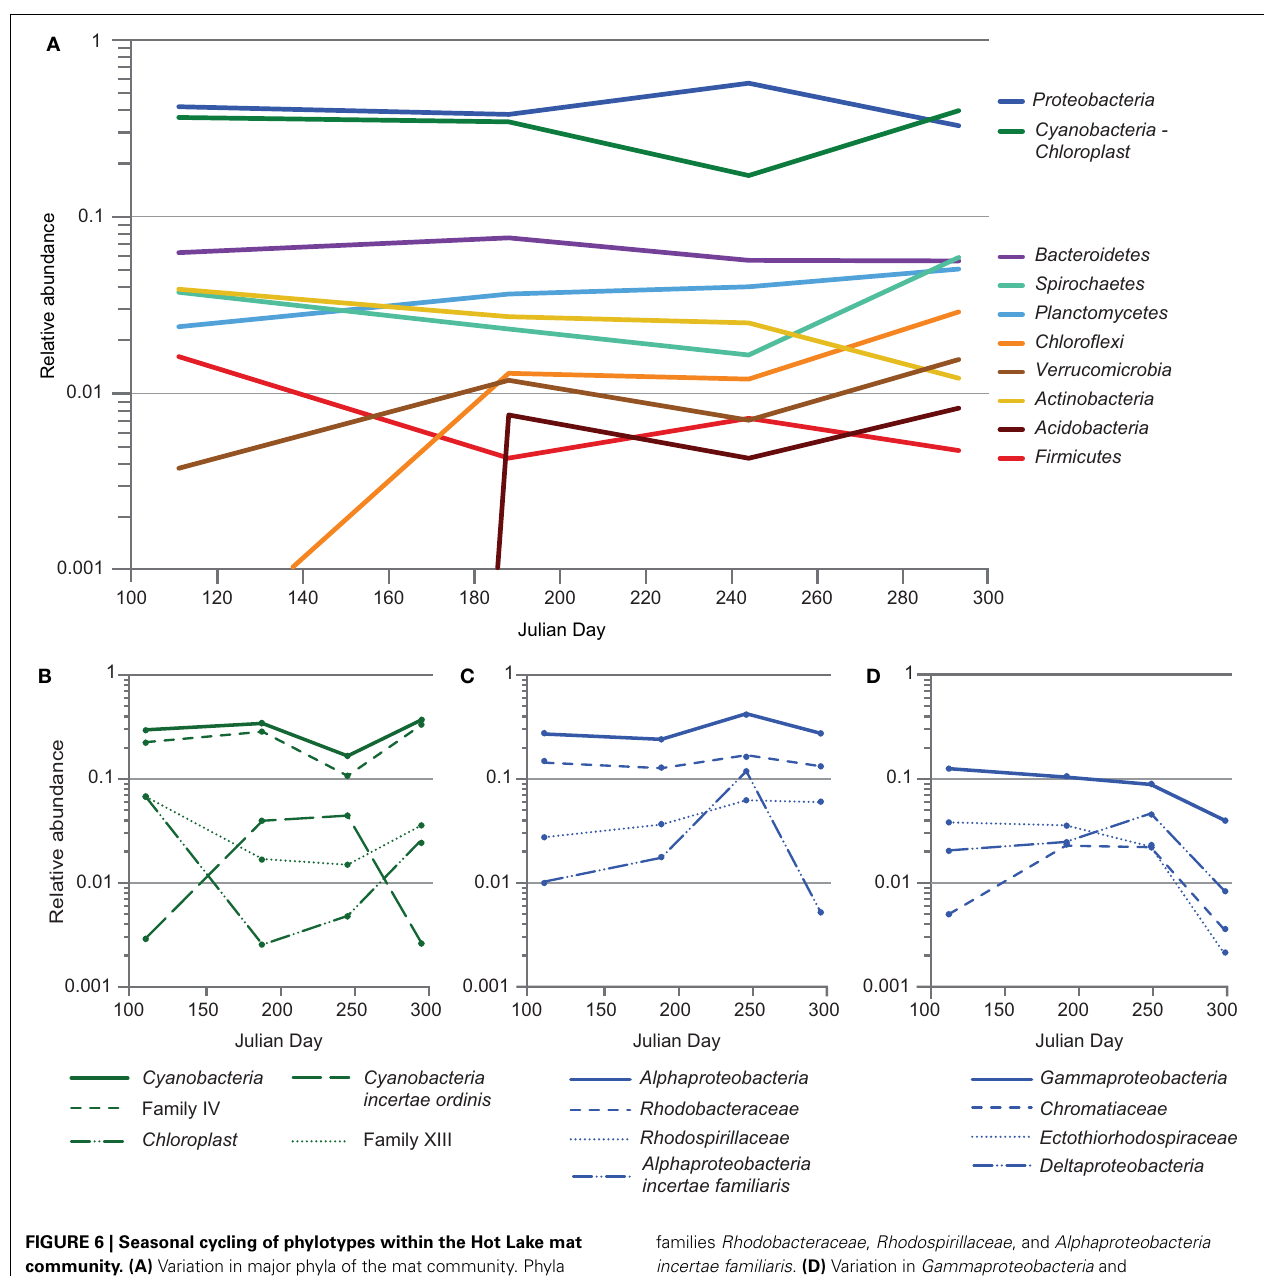
FIGURE 6 | Seasonal cycling of phylotypes within the Hot Lake mat community. (A) Variation in major phyla of the mat community. Phyla representing > 0.5% of the reads for at least one time point were included. (B) Variation in classes Cyanobacteria and Chloroplast . Family IV, Family XIII, and Cyanobacteria incertae ordinis represent subordinate taxa of class Cyanobacteria . (C) Variation in class Alphaproteobacteria and